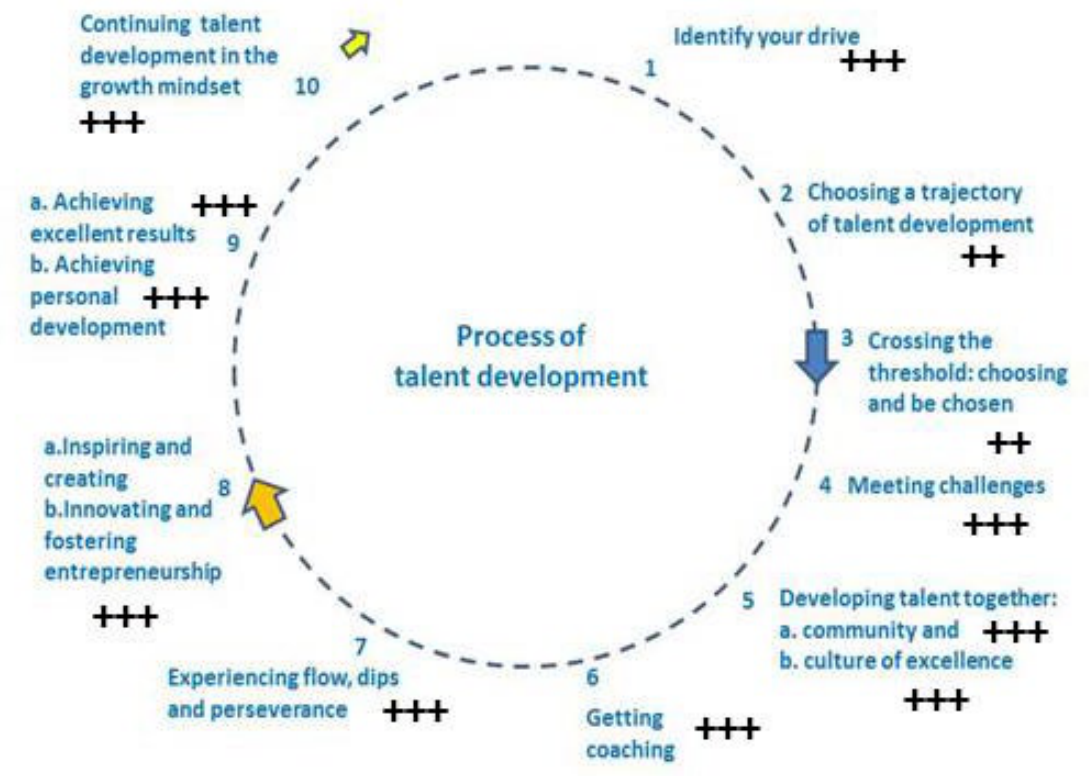
Figure 1: Circle of Talent Development in relation with the good practice ‘Improving and Assessing Honors Student Learning with Learning Portfolios’ with the teacher’s